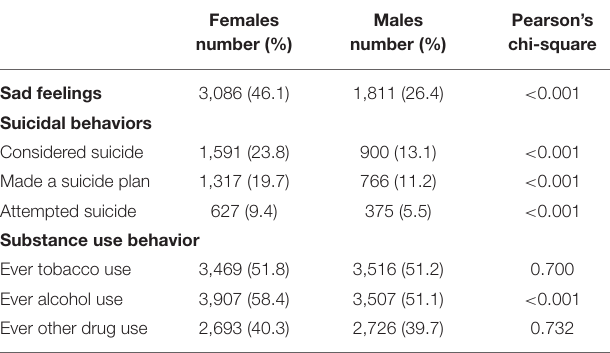
TABLE 2 | Sex stratified prevalence (weighted counts and percent) of sad feelings, suicidal behaviors, and substance use behaviors among high school students in the YRBS 2019 ( N =